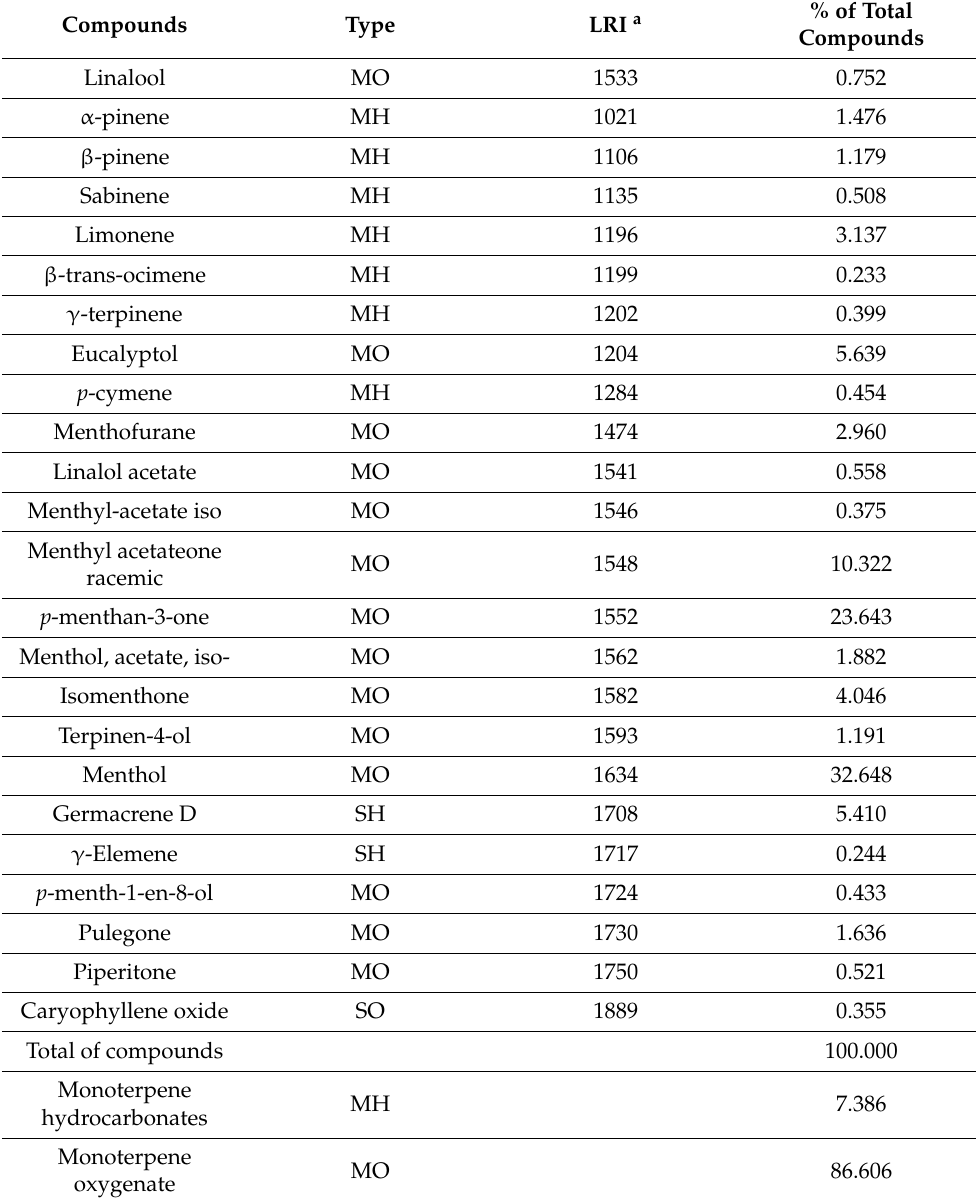
Table 1. Chemical composition of